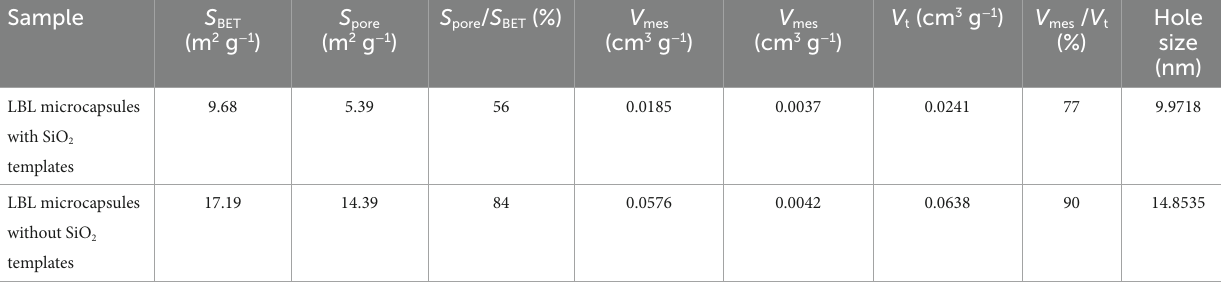
TABLE 1 Surface area, pore size and pore volume parameters for LBL microcapsules.